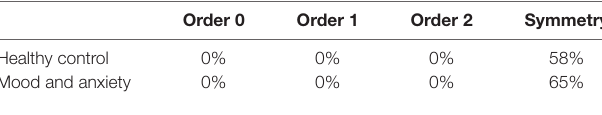
TABLE 1 | Markovian property and symmetry assessment for both